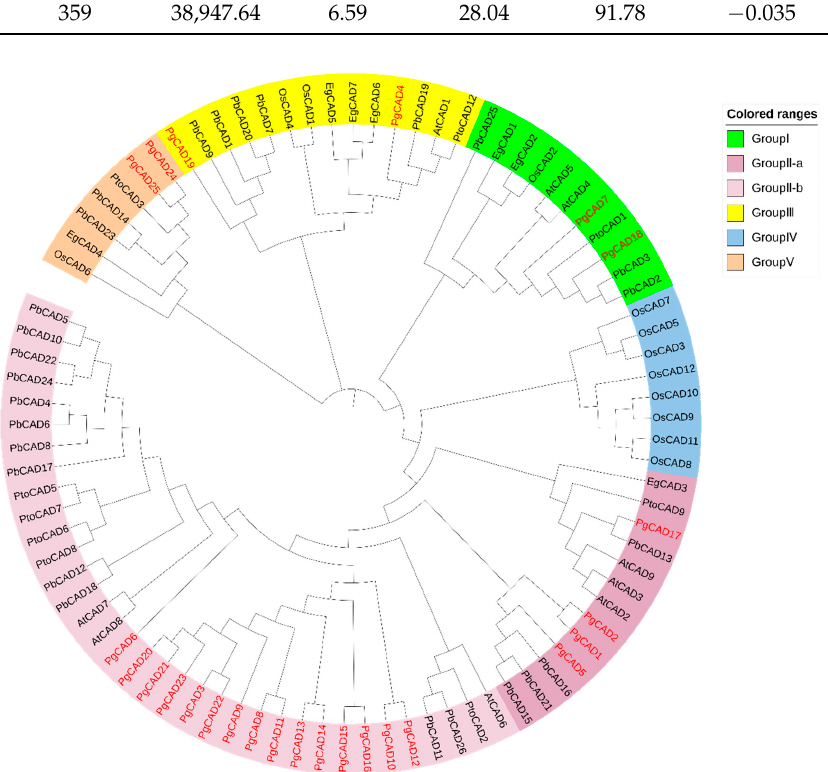
Figure 1. Phylogenetic relationships of cinnamyl alcohol dehydrogenase (CAD) proteins in pomegranate. The color blocks on the right indicate the different groups, and the PgCADs are highlighted in red.